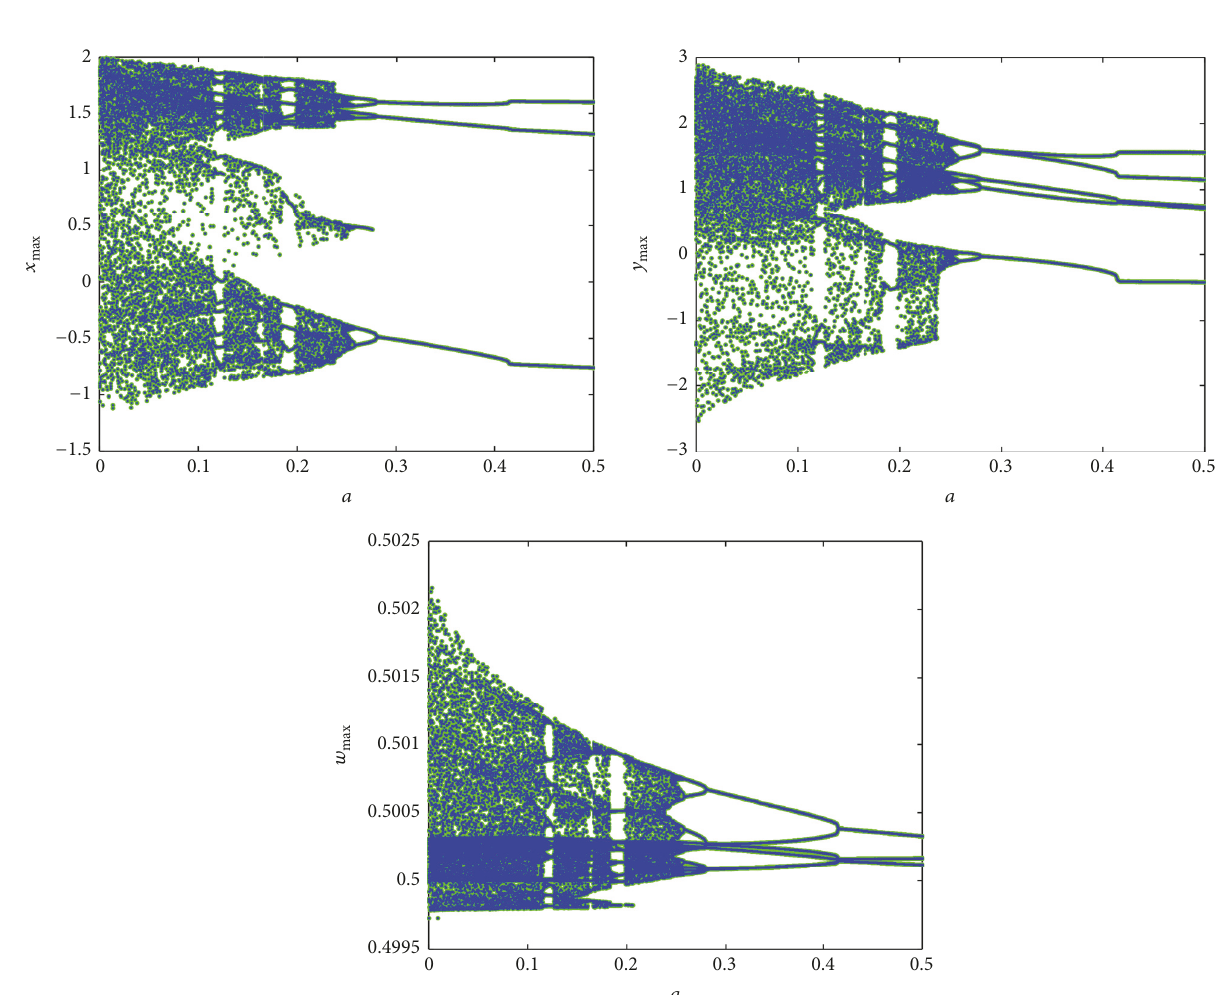
Figure 4: Bifurcation of FOPF system with 𝑎